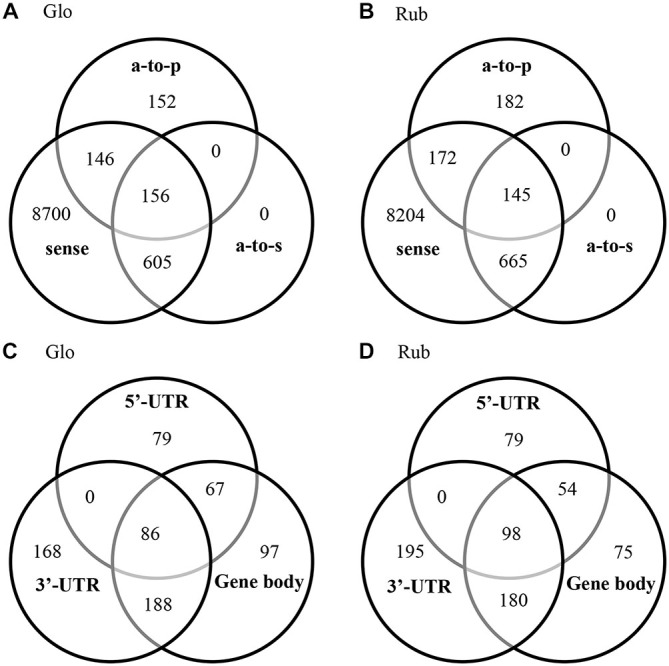
Venn diagrams of the genes with a sense transcript, antisense-to-protein (a-to-p) transcript and antisense-to-sense (a-to-s) transcript in C. glomerata (Glo, A) and C. rubecula (Rub, B). Venn diagrams of alignment of the antisense-to-sense transcripts to (part of) the 5′-UTR region, (part of) the protein-coding region (coding) and (part of) the 3′-UTR region in C. glomerata (Glo, C) and C. rubecula (Rub, D) of sense transcripts that align to N. vitripennis proteins with more than 90% protein coverage. Only the antisense-to-sense transcripts that align to the 5’-UTR, protein-coding region and 3’-UTR, align to the full protein-coding region.